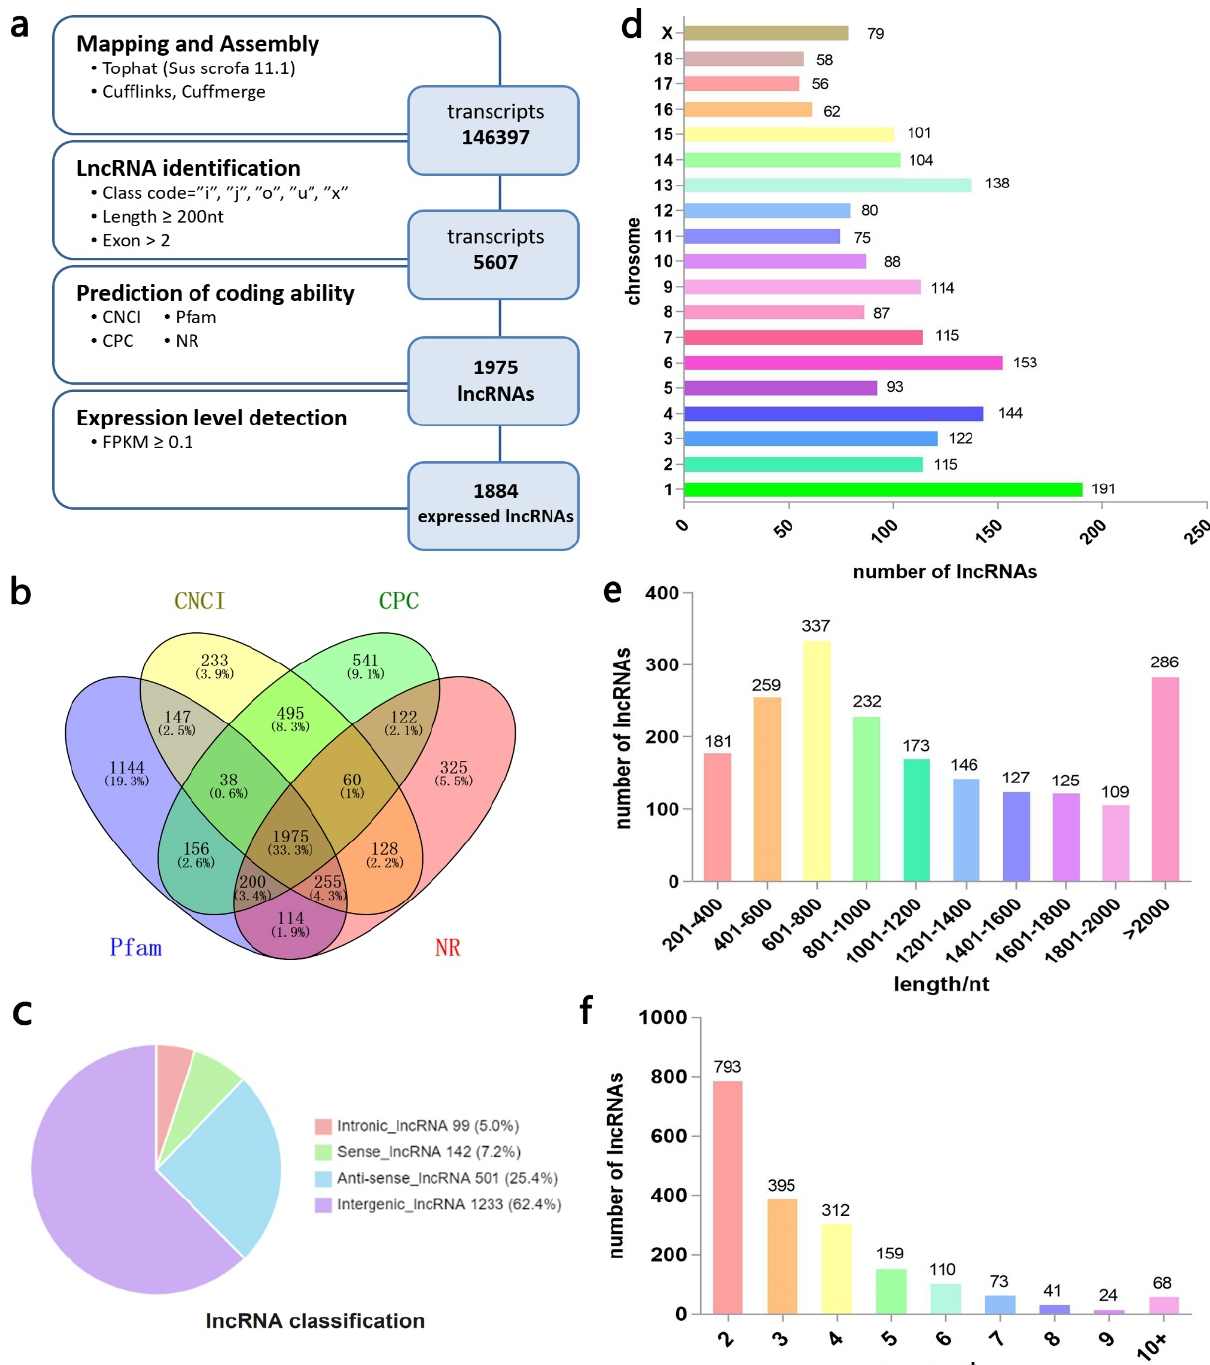
Figure 2. Summary of putative long non-coding RNA (lncRNA) characteristics in Landrace pig backfat. ( a ) Identification pipeline of lncRNAs; ( b ) Venn diagram of identified lncRNAs from the Coding Potential Calculator (CPC), Coding-Non- Coding Index (CNCI), Pfam, and NR database; ( c ) Type and number of putative lncRNAs; ( d ) Chromosome distribution of lncRNAs; ( e ) Length distribution of lncRNAs; ( f ) Exon number distribution of lncRNAs.